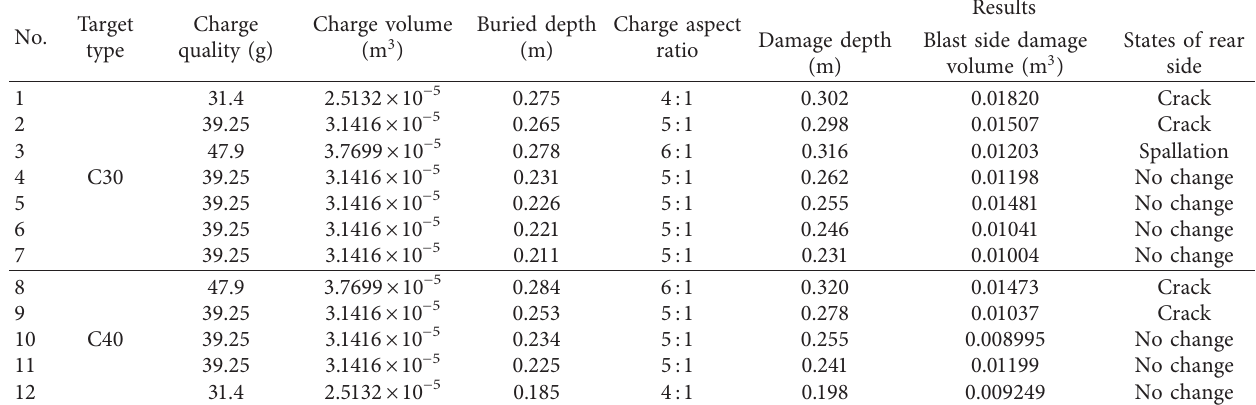
Table 2: Experimental results of penetration-explosion joint damage to concrete targets.